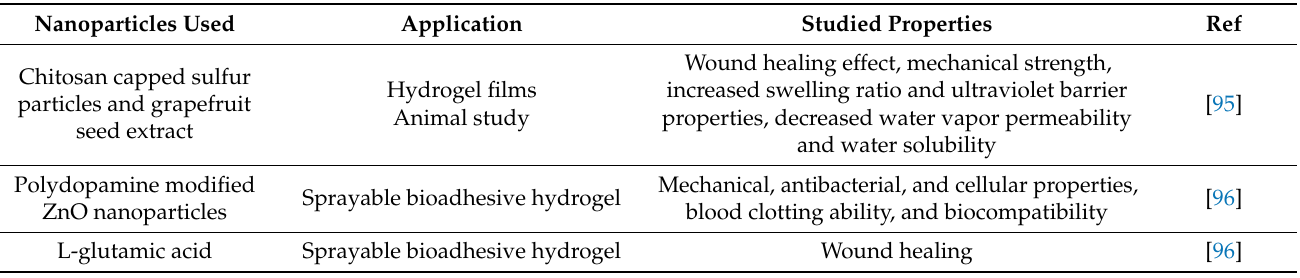
Table 3. Properties of carrageenan nanoparticle